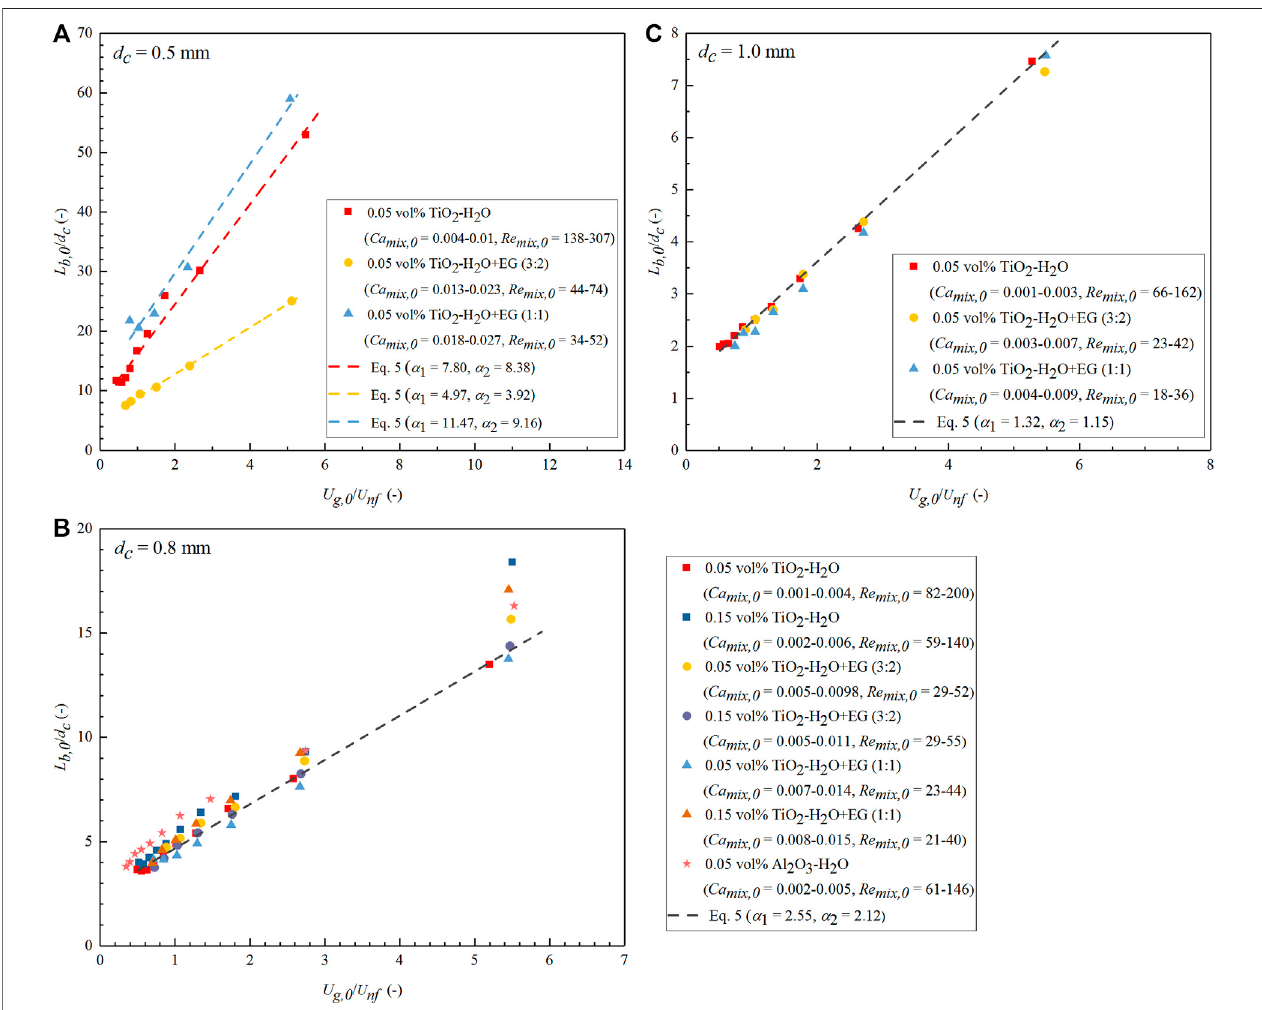
FIGURE 8 | Bubble length as a function of the inlet gas – nano fl uid fl ow ratio in the current PTFE microchannels of different diameters. (A) d c (cid:1) 0.5 mm; (B) d c (cid:1) 0.8 mm; (C) d c (cid:1) 1.0 mm. Symbols represent the experimental data and lines are according to the prediction of Eq. 5 . Ca mix,0 and Re mix,0 represent the capillary number and Reynolds number calculated based on the mixture velocity at the microreactor entrance (i.e., U mix,0 (cid:1) U g,0 + U nf